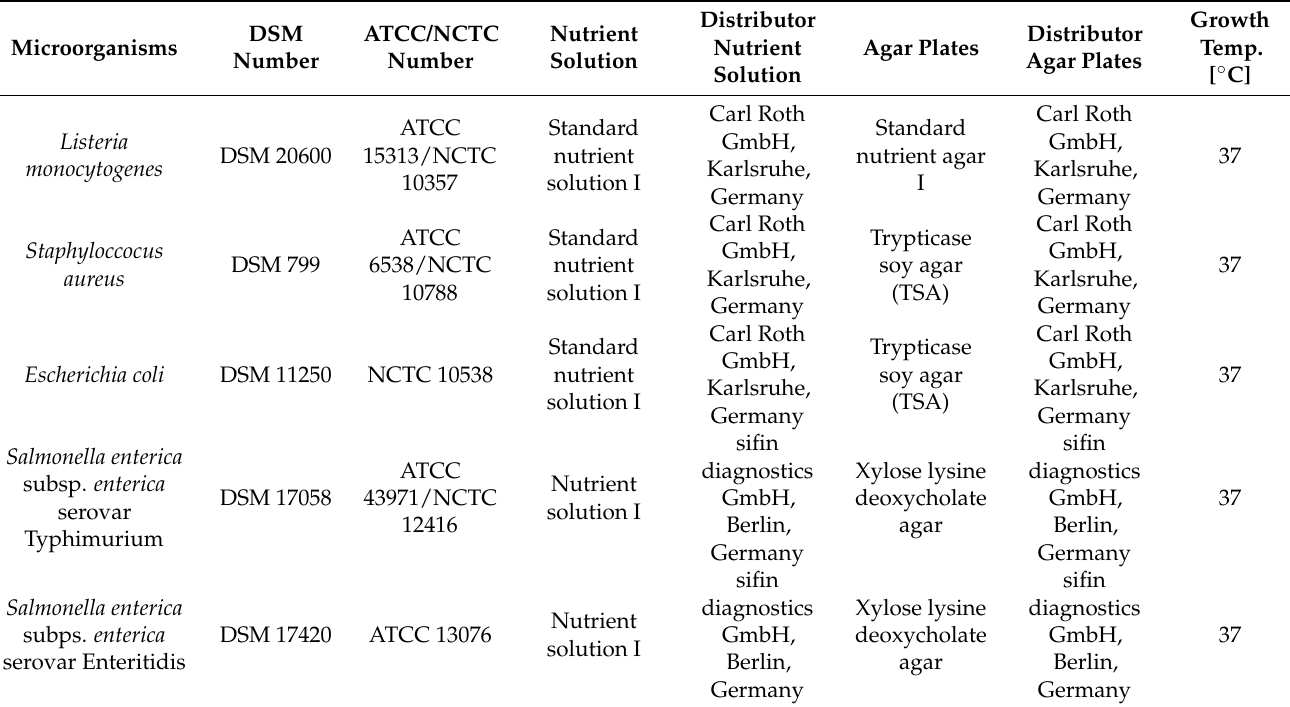
Table 3. Summary of the used microorganisms and their DSM and ATCC/NCTC numbers as well as their growth